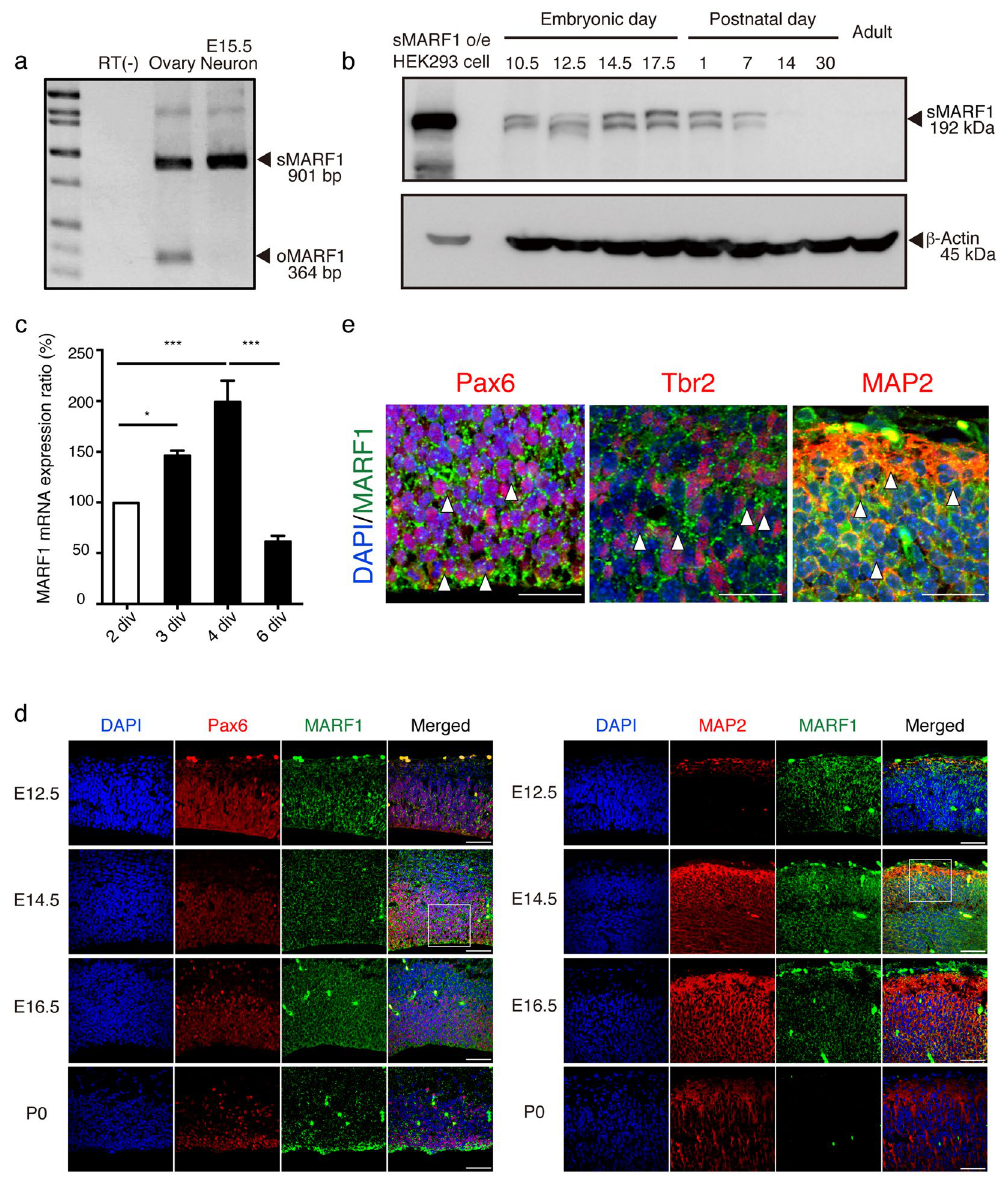
Figure 1. The somatic form of Marf1 ( sMarf1 ) is expressed in the developing cortex. ( a ) RT-PCR analysis for exon 3 of Marf1 mRNA in mouse ovary tissue and E15.5 cultured cortical neurons. The somatic form of Marf1 (sMARF1) contains a longer exon 3 (901 base pairs) than the ovarian form (oMARF1: 364 base pairs). The full-length gel is presented in Supplementary Fig. 8a. ( b ) Western blotting for sMARF1 in mouse cortical lysates at the embryonic, postnatal, and adult ages. β -Actin was used as a loading control. Lysate of HEK293 cells transfected with a sMarf1 expression vector was used as a positive control. The same full-length image is presented in Supplementary Fig. 8b, because membrane was cut before incubating with antibodies. ( c ) Relative expression levels of Marf1 mRNA from E12.5 cortical progenitors cultured for 2, 3, 4 and 6 days (2, 3, 4 and 6 days in vitro (div)). * p < 0.05 *** p < 0.001 (n = 4, one-way ANOVA, Tukey-Kramer test). ( d ) Developmental expression change of sMARF1. Immunostaining for MAP2 (red) or Pax6 (red), DAPI (blue), and MARF1 (green) in coronal sections of the E12.5, 14.5, 16.5 and postnatal day 0 mouse cortices. Scale bar, 50 μ m. ( e ) Magnified images of E14.5 mouse cortex immunostained for Pax6, Tbr2 or MAP2. White arrowheads indicate MARF1 and Pax6 + radial glia (left-panel), MARF1 and Tbr2 co-expressing differentiated basal progenitors (middle-panel), or MARF1 and MAP2 + post-mitotic neurons (right-panel). Scale bar, 25 μ